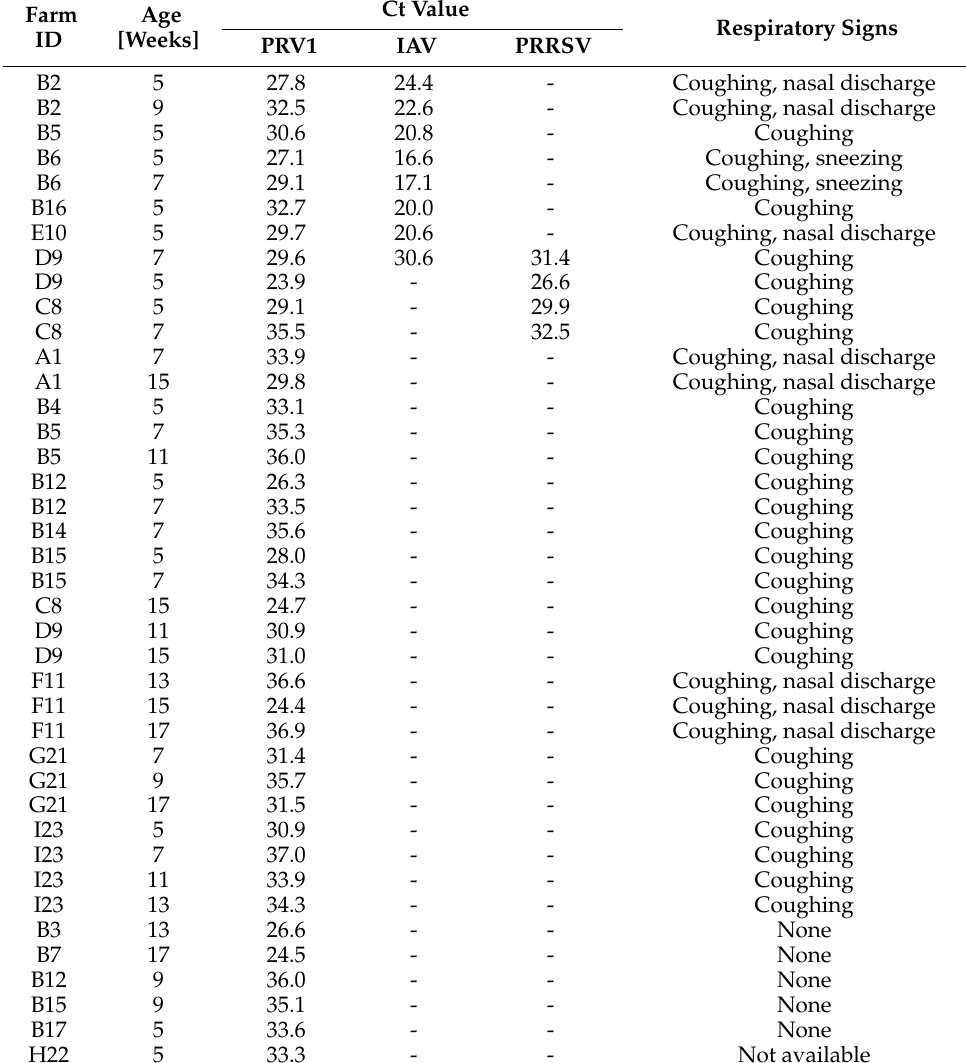
Table 2. Results of real-time PCR for IAV and PRRSV detection in PRV1-positive nasal swab pools expressed as Ct values. Ct ≤ 37 was considered positive. Health status was reported by veterinary practitioners based on subjective